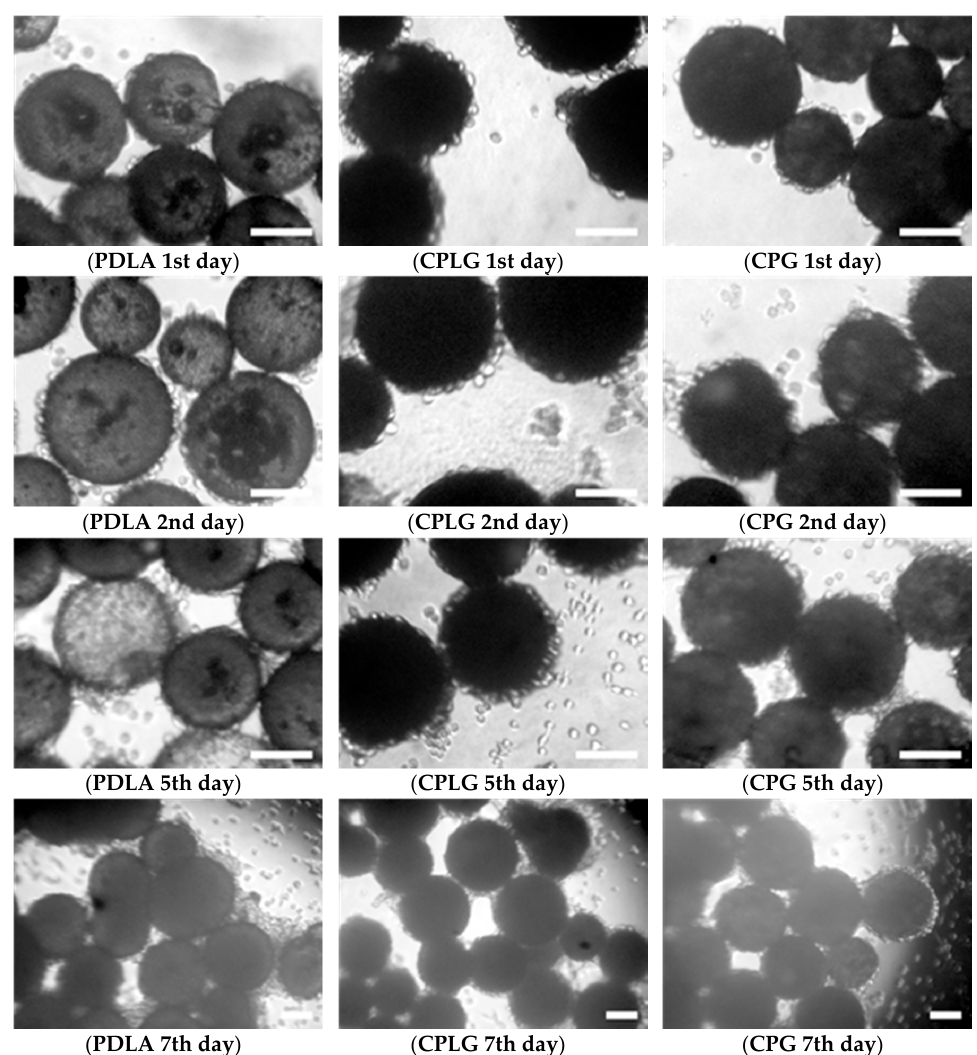
Figure 6. Microphotographies of L929 fibroblasts cultured on CPLG, CPG and PDLA microparticles. Scale bar is 100 μ m.